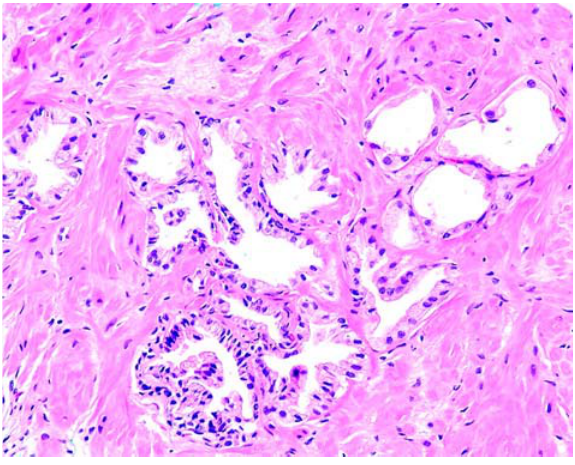
Figure 2 – Partial atrophy.